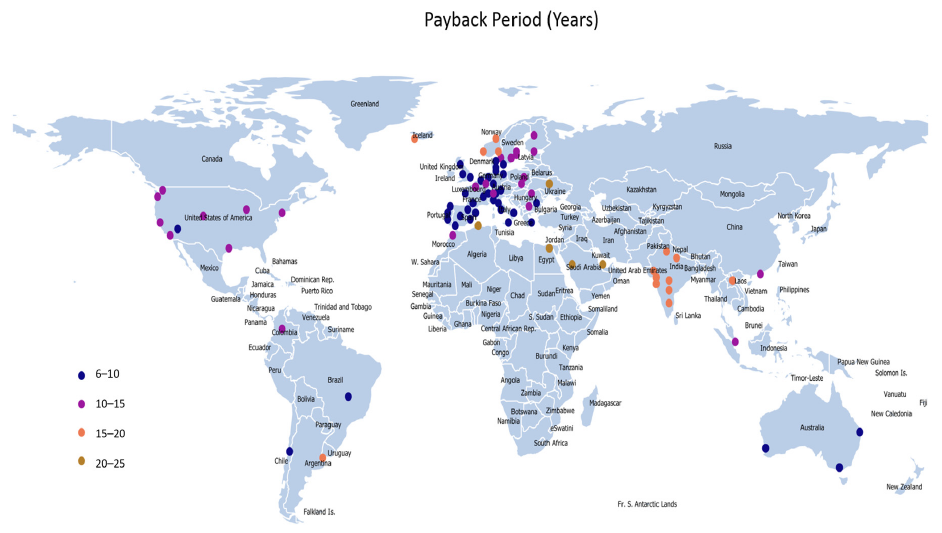
Figure 22. Country-wise average payback period of the PVT collector system.